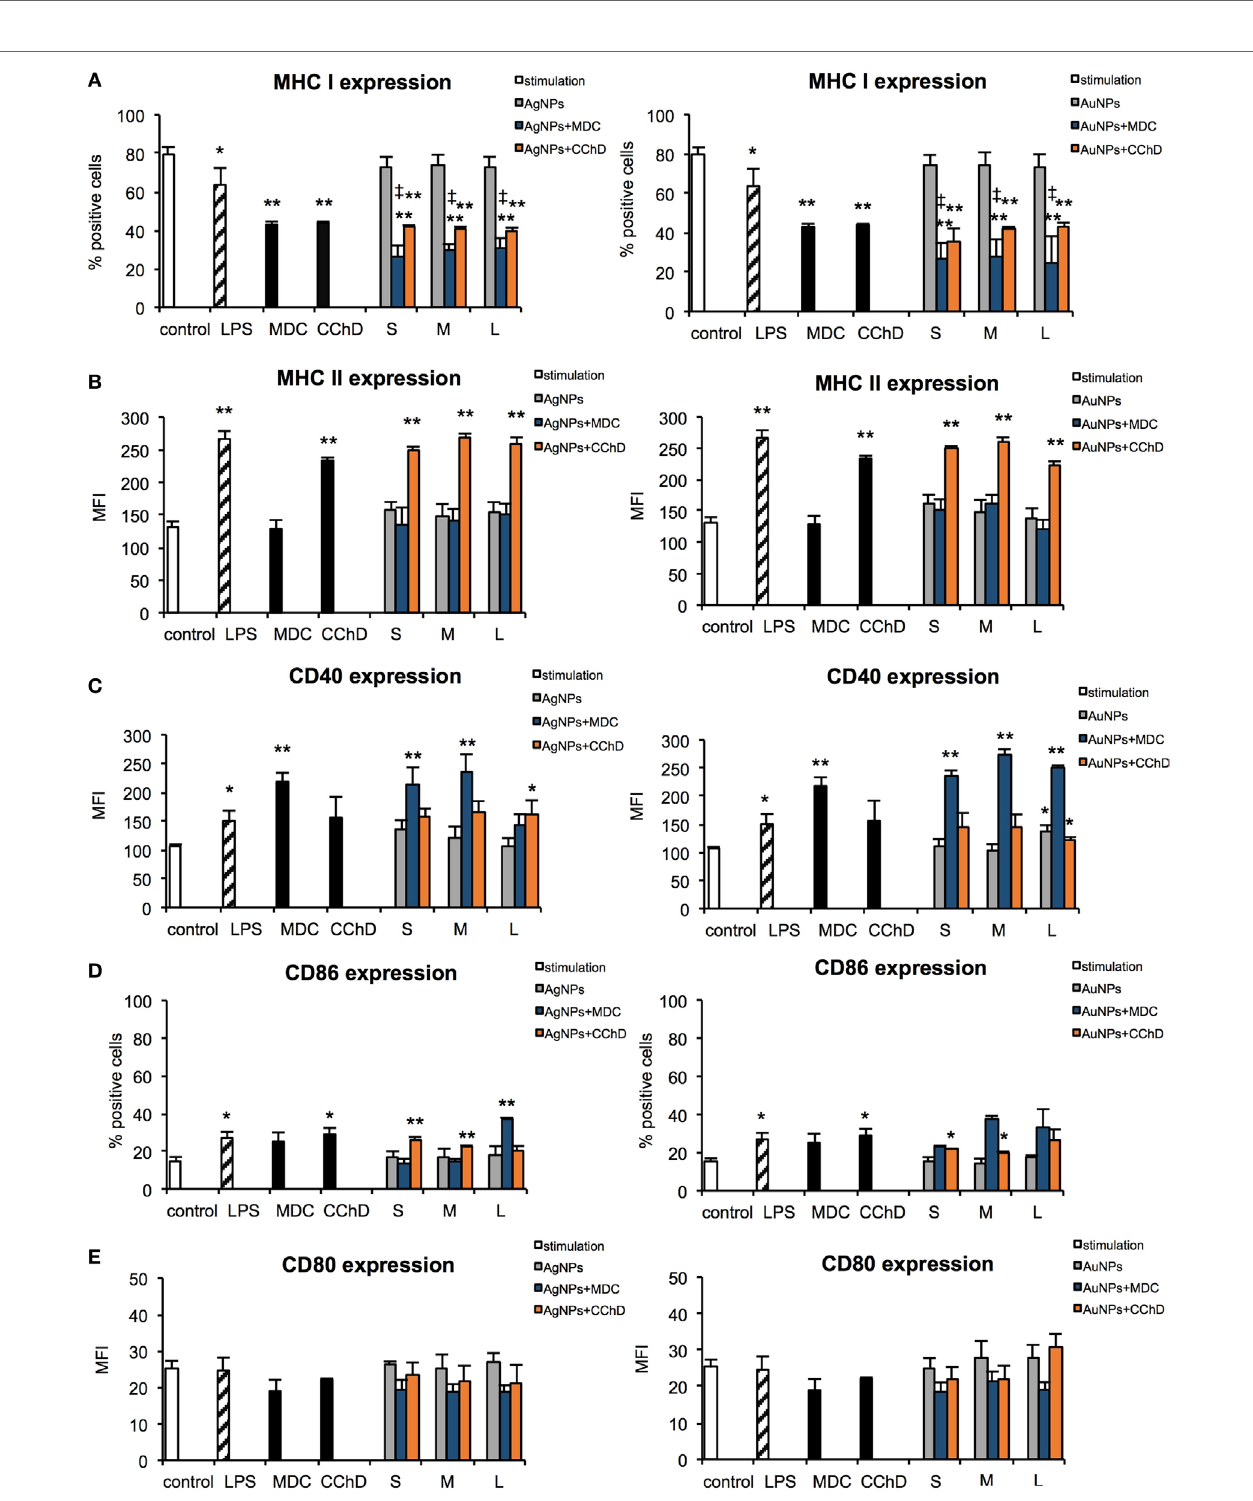
FigUre 7 | Effect of nanoparticles (NPs) on expression of surface activation markers in the presence of endocytosis and phagocytosis inhibitors. MHC class I (a) , MHC class II (b) , CD40 (c) , CD86 (D) , and CD80 (e) expression on the JAWS II cells after 6 h exposure to 2.5 µg/ml 10 nm (S), 37 nm (M), 59 nm (L) TA-AgNPs and 10 nm (S), 34 nm (M), 62 nm (L) TA-AuNPs with or without pretreatment with 10 µg/ml monodansyl cadeverine (MDC), and 5 µg/ml cytochalasin D (CChD). Each bar represents the mean from three experiments ( N = 3) ± S.E.M. *Significant differences with p ≤ 0.05, ** p ≤ 0.01 in comparison to untreated control, ‡Significant differences with p ≤ 0.05 in comparison to inhibitor